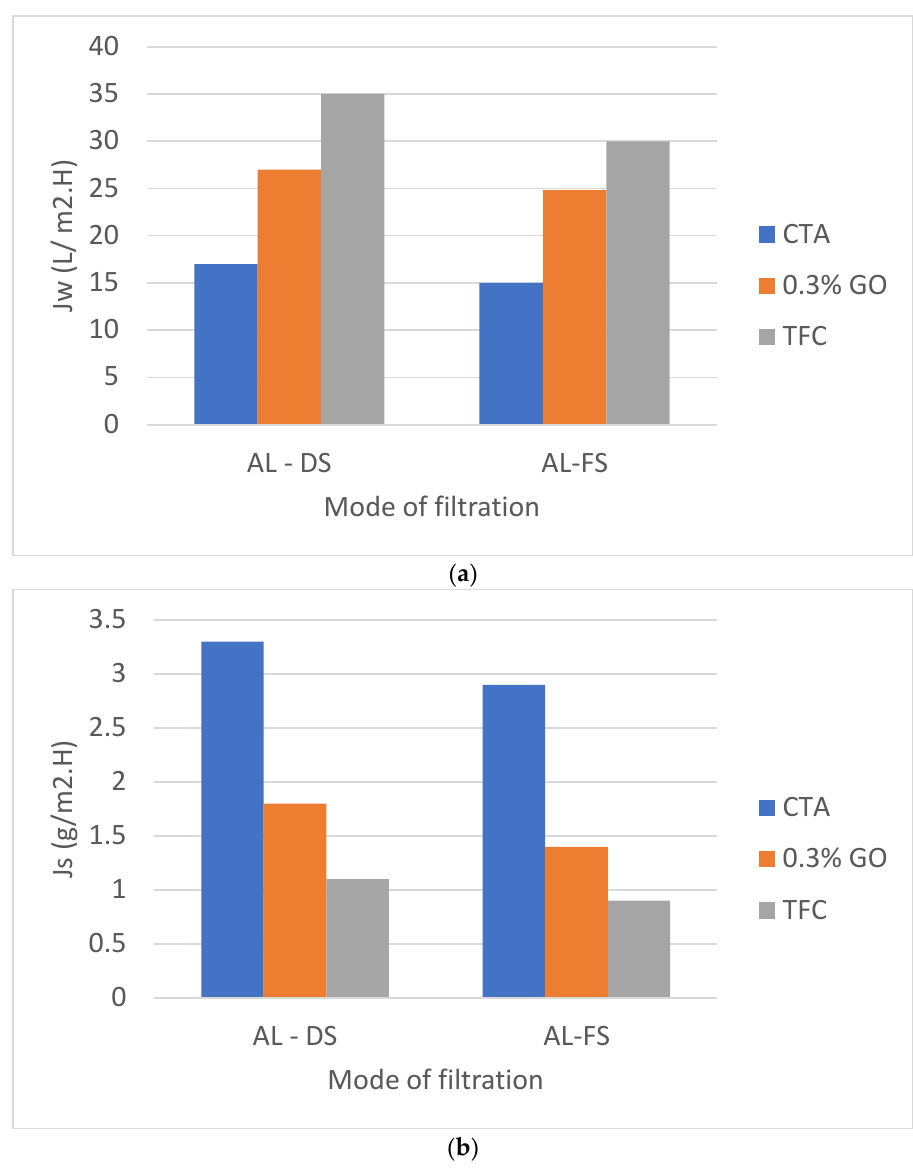
Figure 12. The effect of membrane orientation on ( a ) the water flux and ( b ) the reverse salt flux of TFC (CTA/0.3% GO) substrate compared with CTA/0.3% GO and pure CTA membrane.